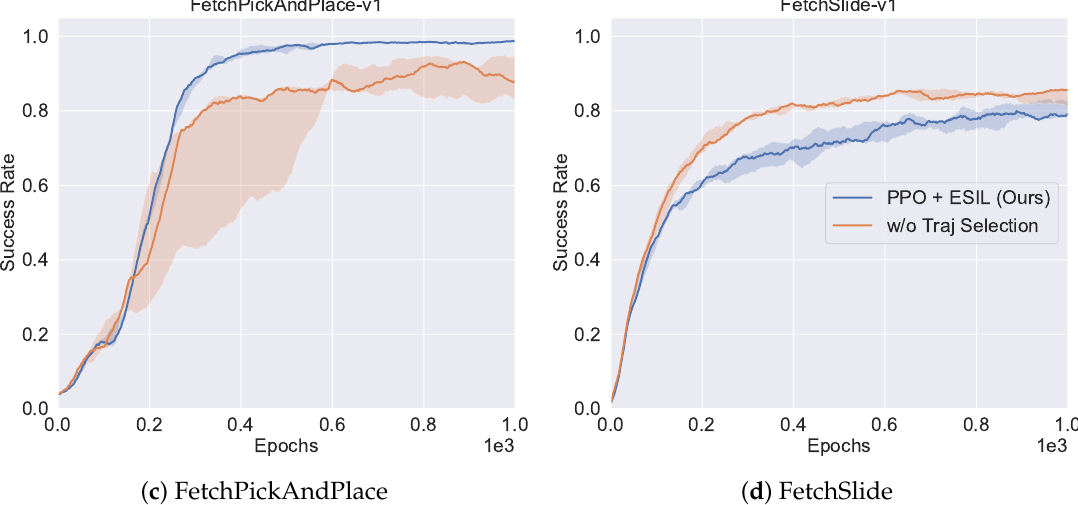
Figure 6. Results of ablation studies with or without using trajectory selection module on all Fetch environments.